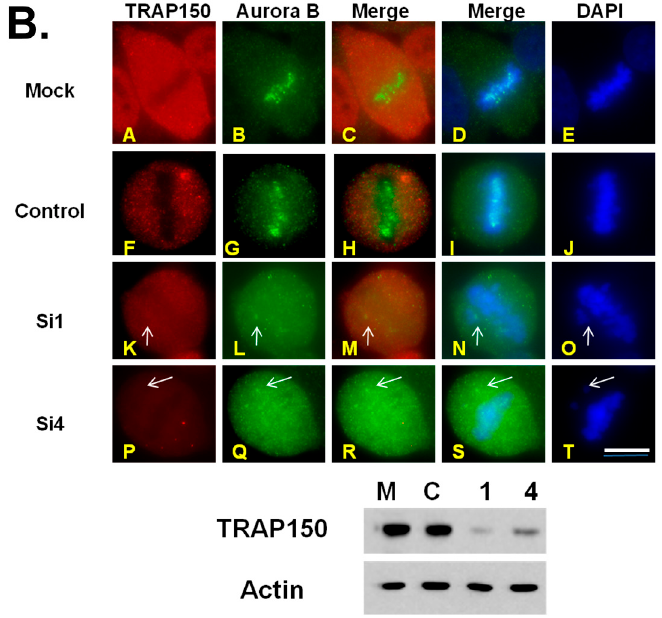
Figure 5. Aurora B localizes to misaligned chromosomes at metaphase in Btf-depleted cells. HeLa cells were treated with mock conditions (siRNA buffer), siRNA against control luciferase, Btf siRNA duplexes ( A ), or TRAP150 siRNA duplexes ( B ). Seventy-two hours (72 h) post-transfection, the cells were processed for immunolocalization of Btf/TRAP150, Aurora B (B,G,L,Q), and ACA (C,H,M,R). DNA was stained with DAPI. Arrows indicate misaligned chromosomes. Immunoblot confirmed the depletion of Btf/TRAP150, and β -Actin was used as a loading control. Scale bar = 5 μ m.